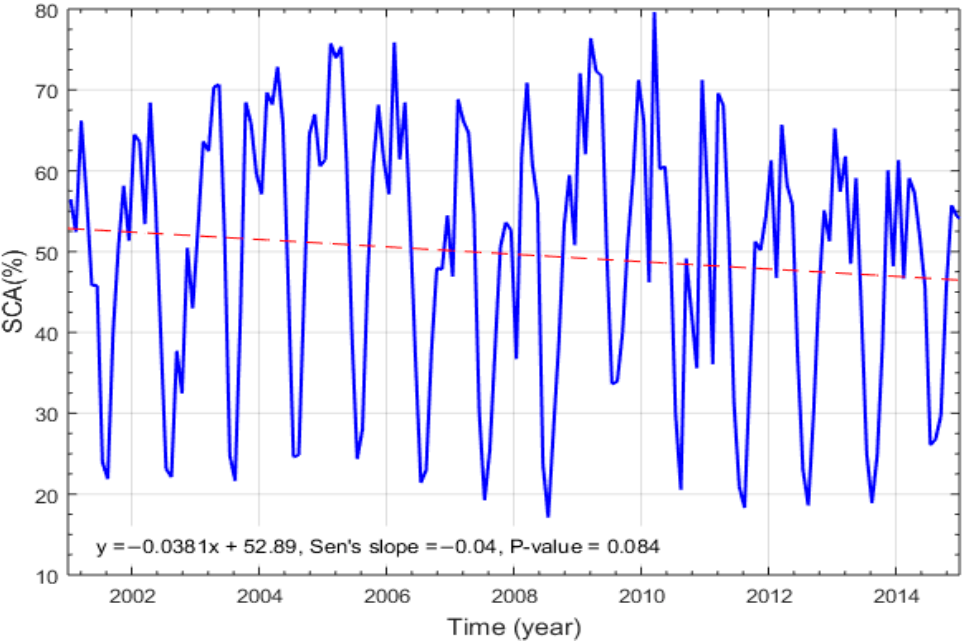
Figure 4. Snow cover trend in Gilgit River Basin from 2001 to 2015 by using MODIS 8-day product .